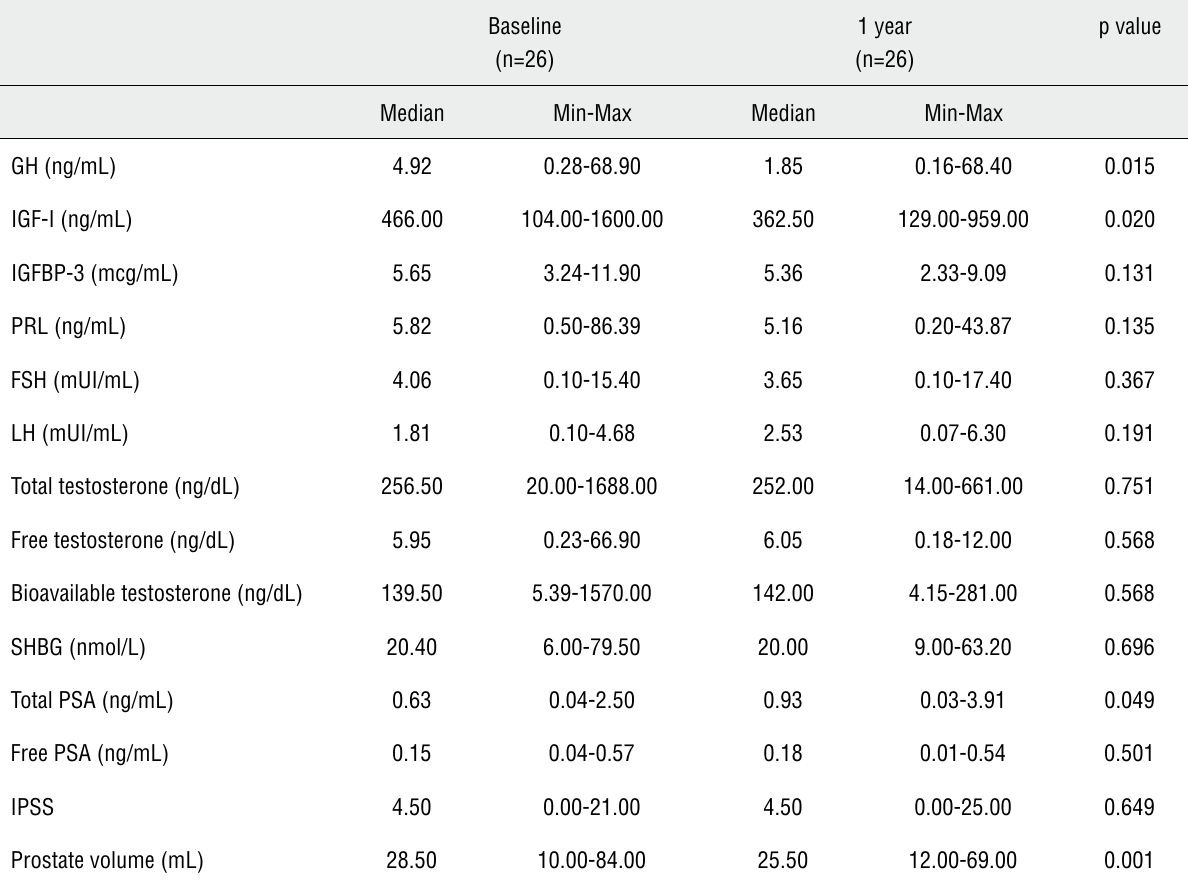
Table 4 - Characteristics of acromegalic patients at baseline and after one year of treatment ( ≥ 40 years-old).